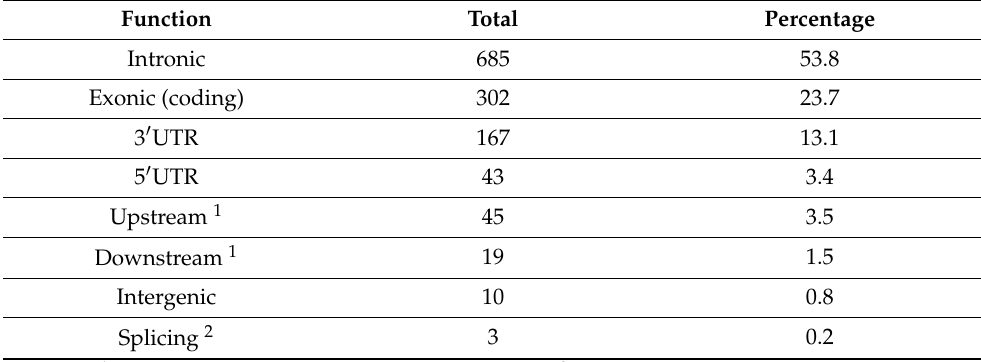
Table 1. Observed alterations in cytochromes P450 divided by function according to Annovar.